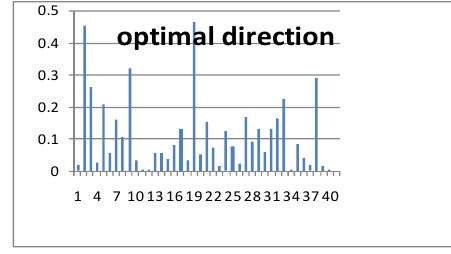
Fig.7. Optimal direction in one-dimension projection